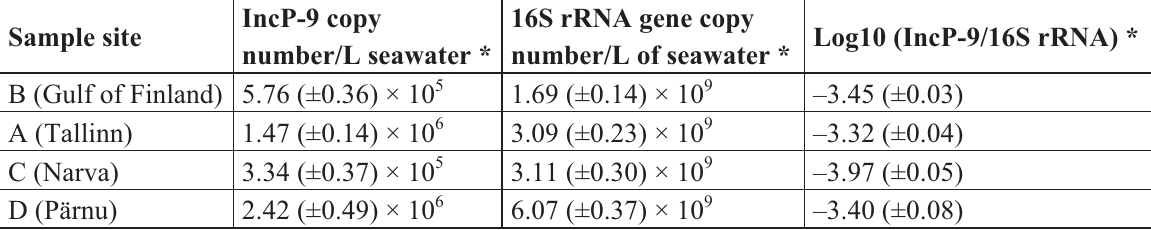
Table 4. Abundance of IncP-9 repA gene and 16S rRNA gene and the log10 transformed ratio of IncP-9 to 16S rRNA gene copies in different sampling